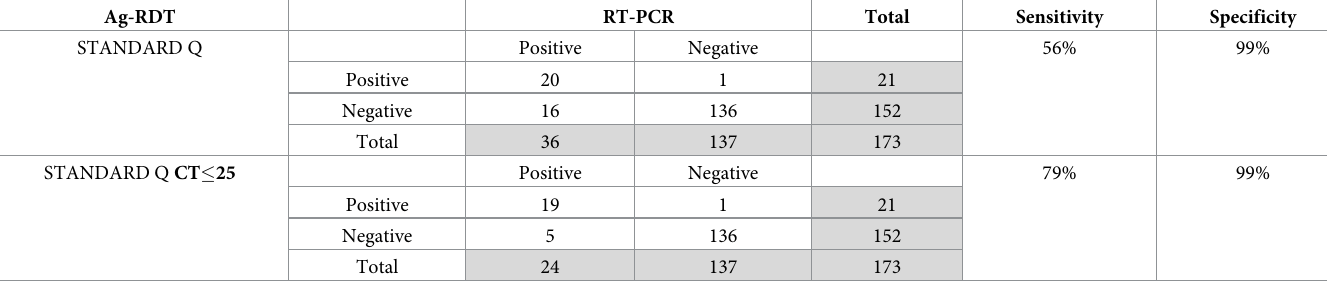
Table 4. Field sensitivity and specificity of the STANDARD-Q Ag-RDT.